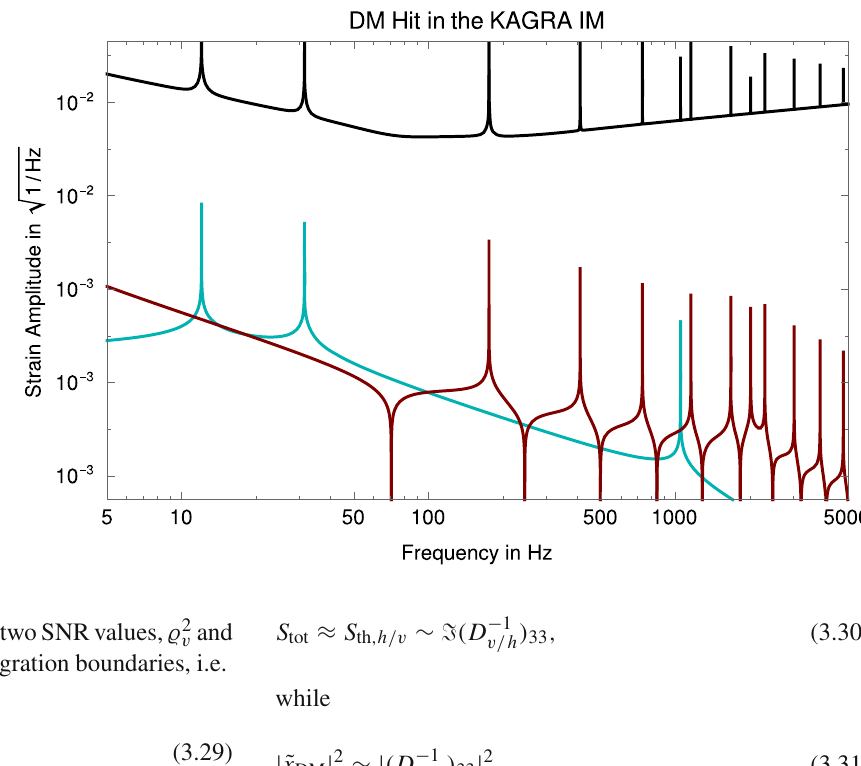
Fig. 5 Comparison of strain amplitudes of noise shown as black line and a DM hit in the IM in vertical (horizontal) direction shown as aqua (maroon) line. For more details, see main